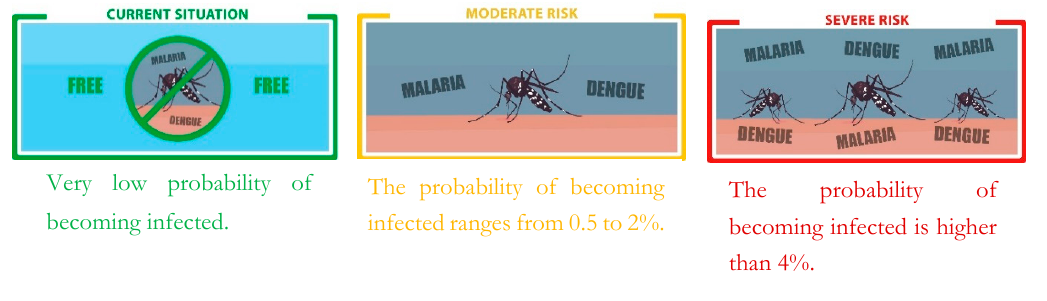
Figure 1. Attribute levels for infectious diseases. Figure1. Attribute levels for infectious diseases.